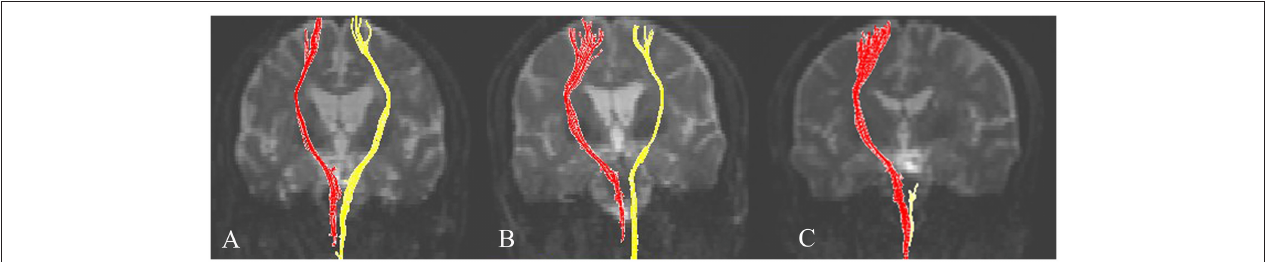
Frontiers in Neurology |